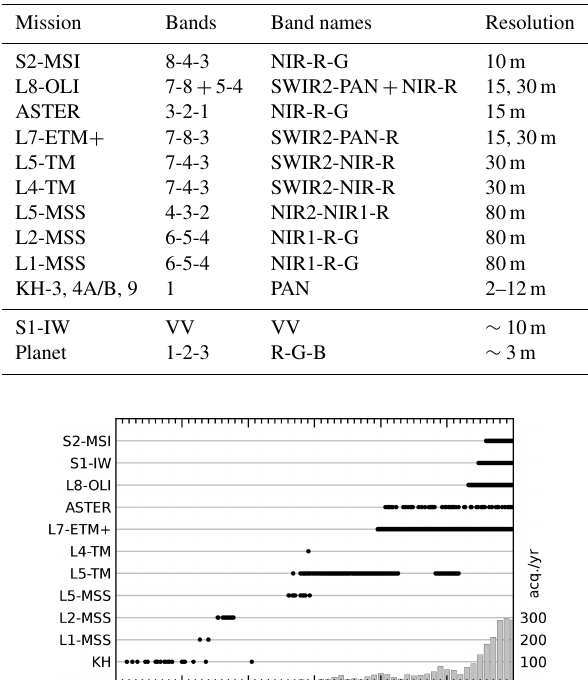
Table 1. List of satellite imagery that was systematically analyzed (upper rows) and used to narrow down event dates (lower rows).